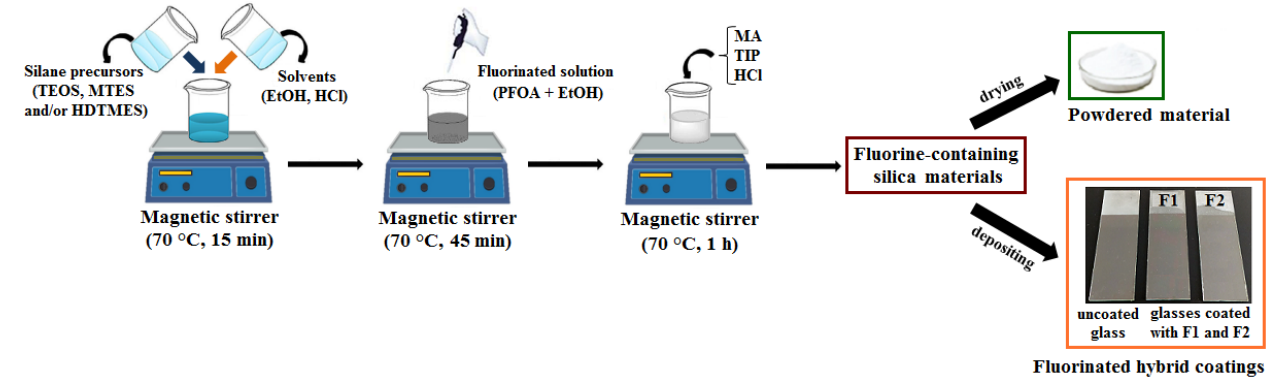
Figure 1. Schematic illustration of synthesis procedure to obtain fluorinated silica materials as powdered materials and as fluorinated hybrid coatings.